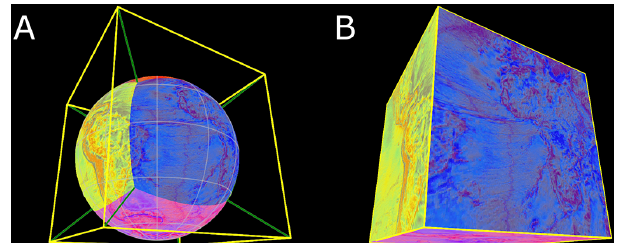
Figure 3. A global free-air gravity raster (Andersen et al., 2010) highlighted with solid colours representing the faces of a cube. Each cube face and the globe centre represent a perspective (pyra- mid) frustum. The yellow wireframe represents the cube and the green wireframe represents the edges of the six pyramid frusta. (A) Coloured raster regions captured by the pyramid frusta of the cube faces; (B) coloured raster regions radially projected onto the cube faces (from the globe